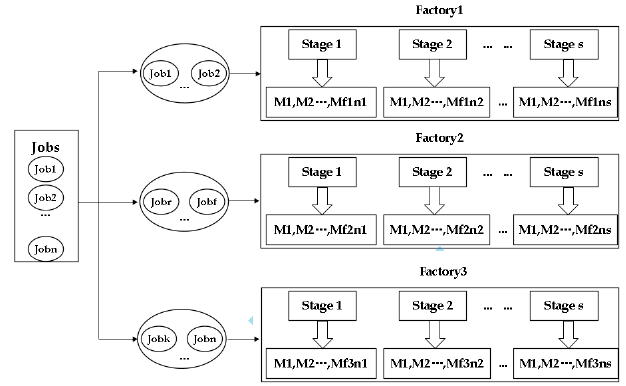
Figure 1. Schematic diagram of the DRHFS problem.